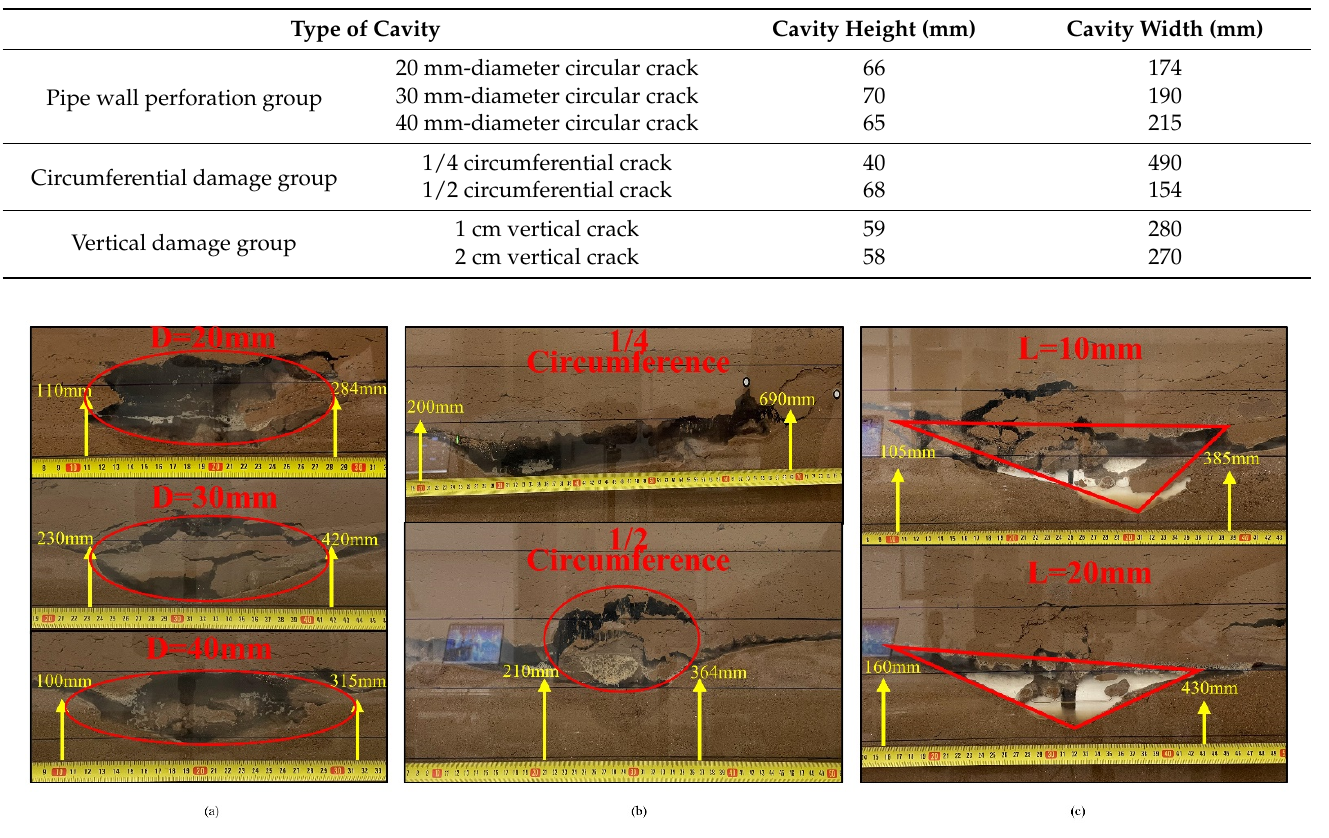
Table 1. Dimensions of cavity for different damage types.